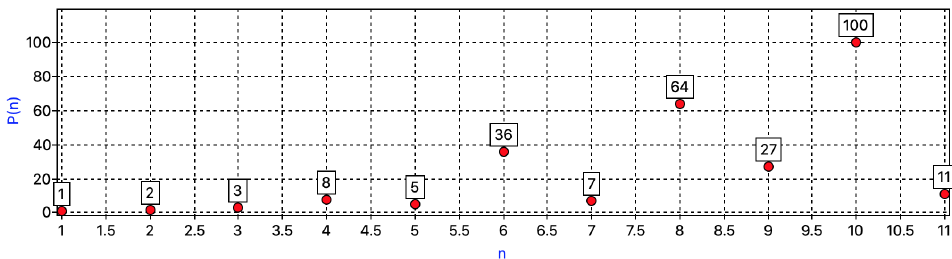
Figure 10. The simulation for P ( n ) with 1 ≤ n ≤